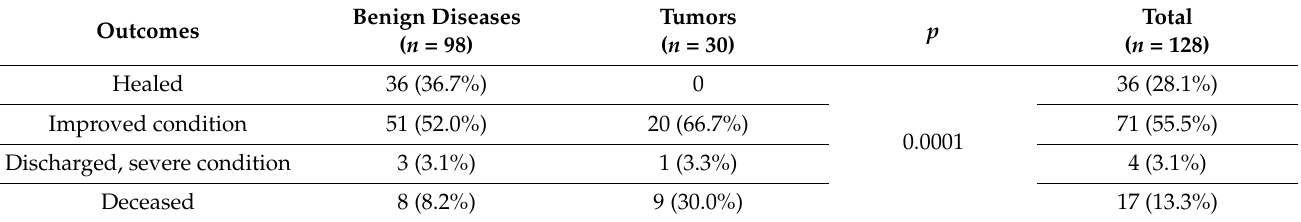
Table 7. Outcomes of tumorous and non-tumorous